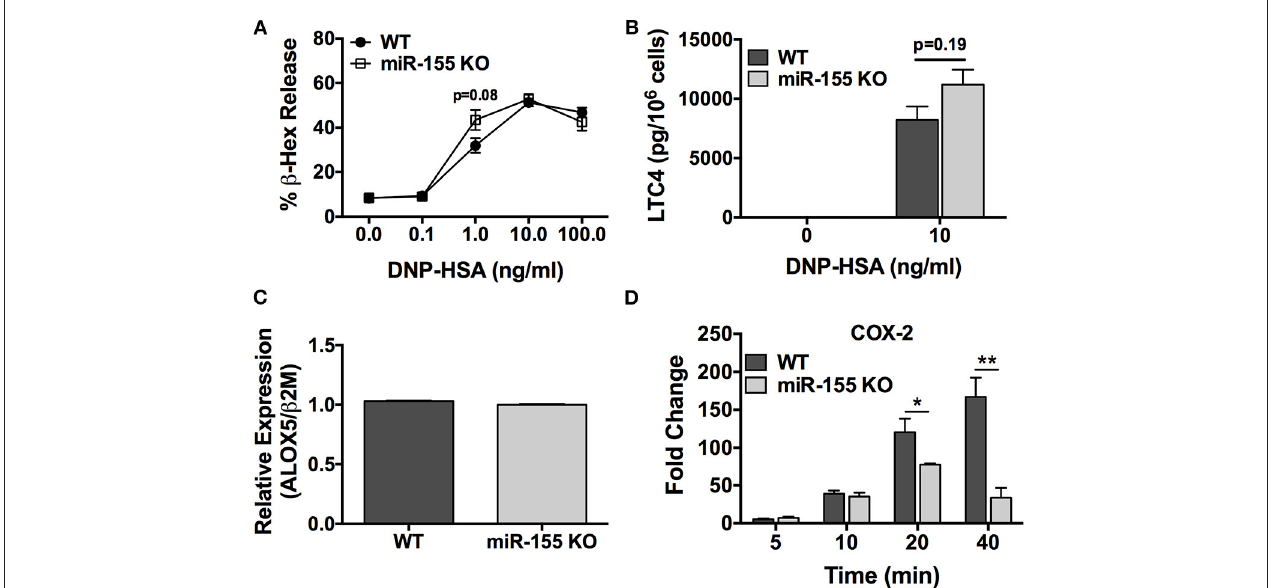
FIGURE 4 | Fc ε RI-induced COX-2 expression, but not degranulation, is impaired in miR-155 KO BMMCs. Wild-type and miR-155 KO BMMCs were sensitized with anti-DNP-IgE and challenged with multivalent antigen DNP-HSA. (A) Dose-dependent degranulation response of wild-type and miR-155 KO BMMCs after 30min activation period. Degranulation was determined by β -hexosaminidase release. (B) Leukotriene C4 (LTC 4 ) biosynthesis after 30min activation period. (C) Expression of ALOX5 in non-activated wild-type and miR-155 KO BMMCs. Analysis performed was quantitative RT-PCR. (D) Time-course for Fc ε RI-induced COX-2 expression in wild-type and miR-155 KO BMMCs. Fold change in COX-2 expression was determined by quantitative real-time PCR. The figures represent mean ± SEM of values obtained from independent experiments with 3–6 different BMMC cultures of each genotype from different mice. Significance was determined with Student’s t -test. * p < 0.05; ** p < 0.01.